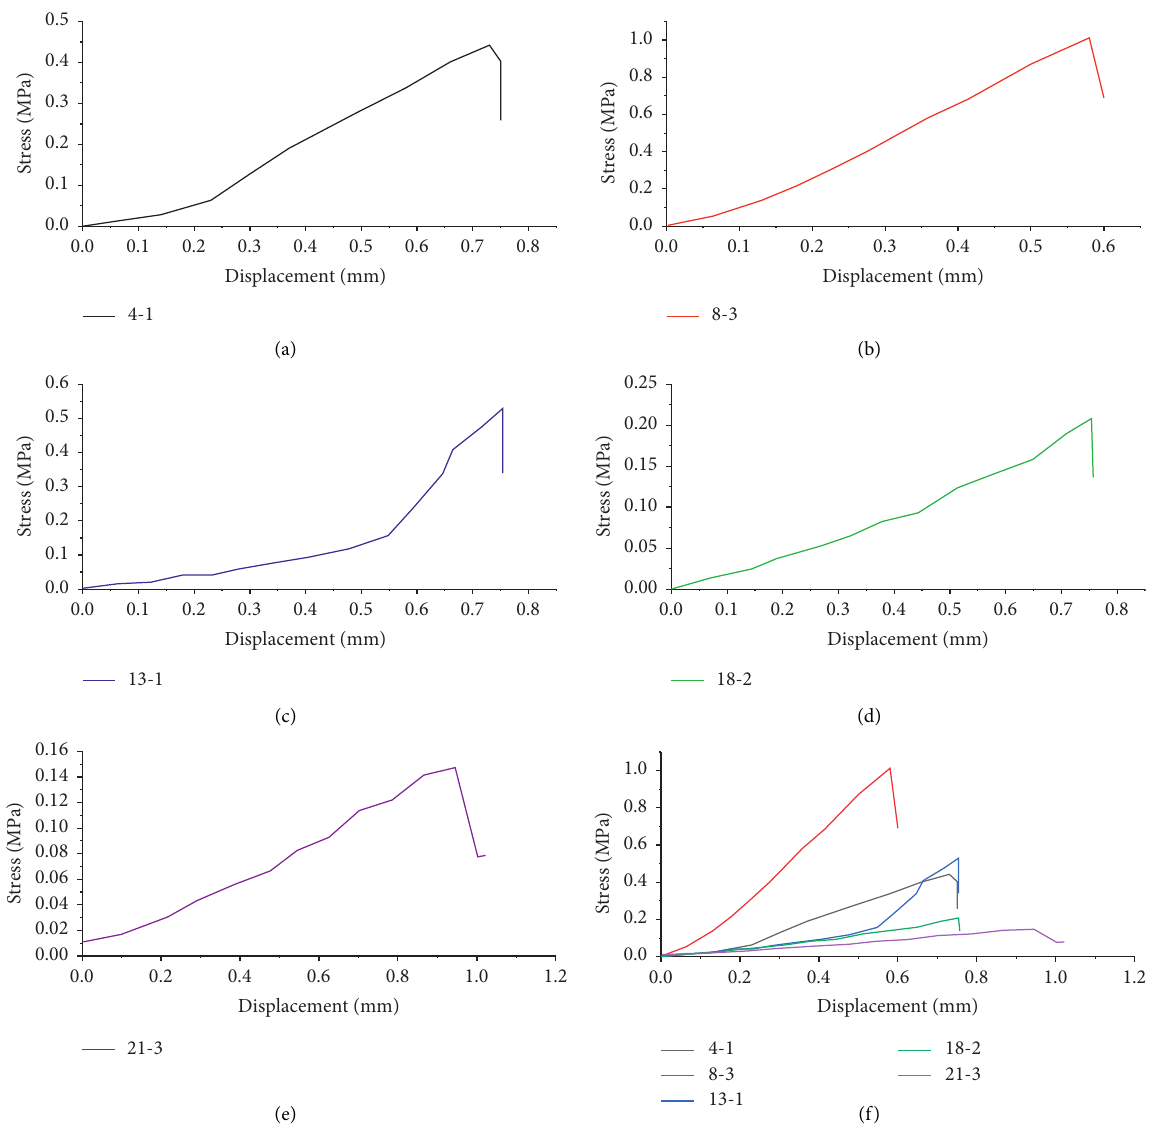
Figure 11: Typical stress-displacement curves of splitting